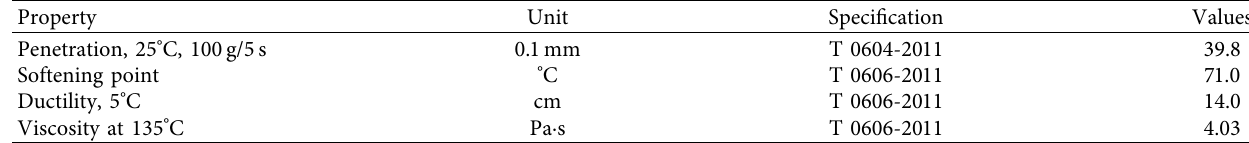
Table 1: Basic indexes of SBS-modifed asphalt.